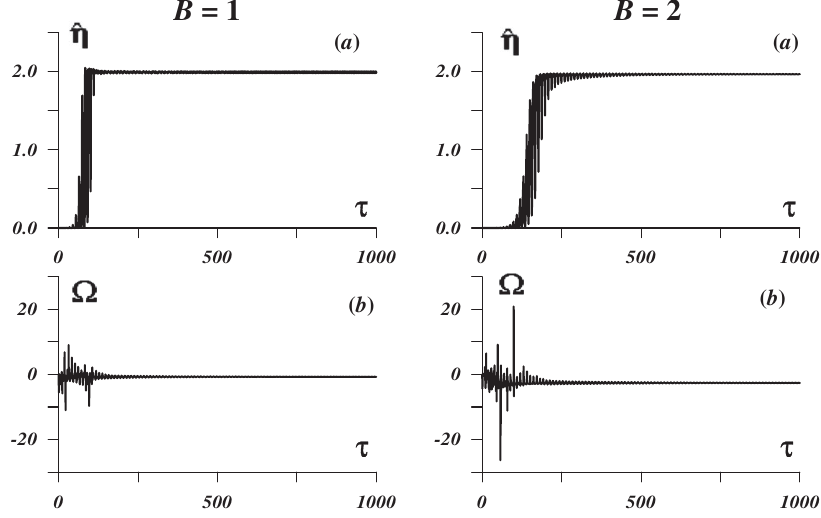
FIG. 2. Establishment of steady-state oscillations at various values of the gap parameter: B ¼ 1 (left, (cid:4) 1 ¼ 4 , (cid:4) 2 ¼ 1 ), B ¼ 2 (right, (cid:4) 1 ¼ 2 , (cid:4) 2 ¼ 0 : 5